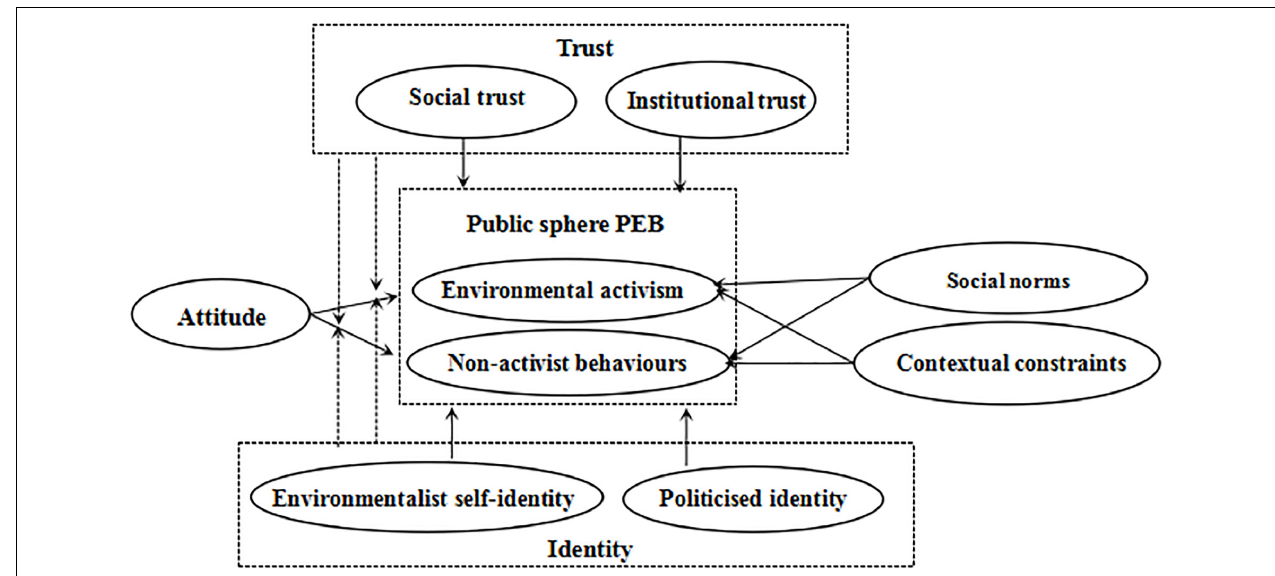
FIGURE 1 | The research